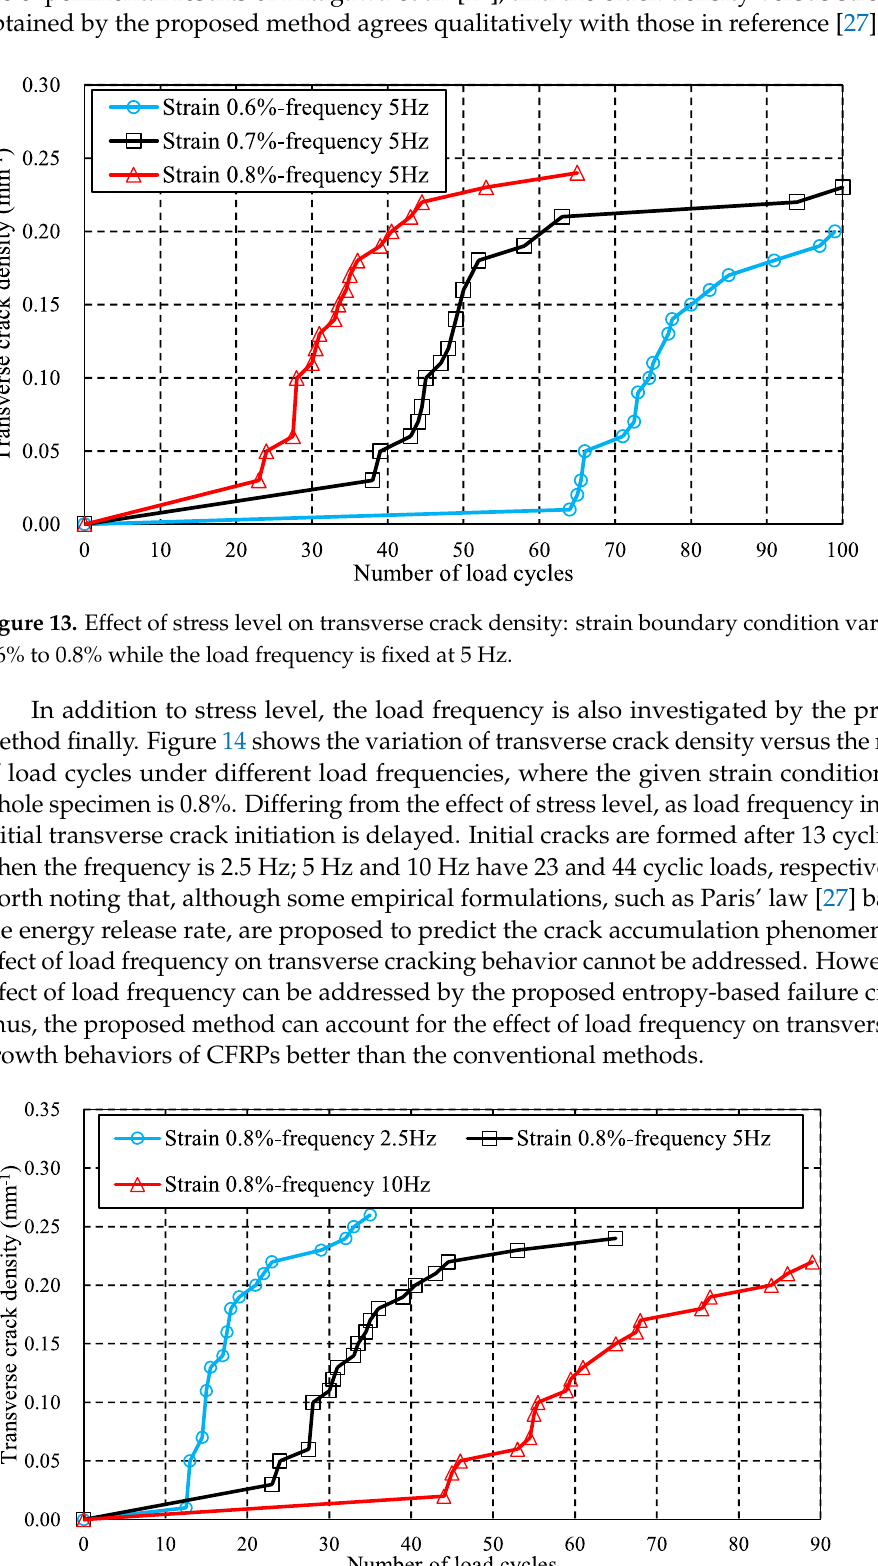
Figure 14. Effect of load frequency on transverse crack density: load frequency varies from 2.5 Hz to 10 Hz while the strain boundary condition is fixed at